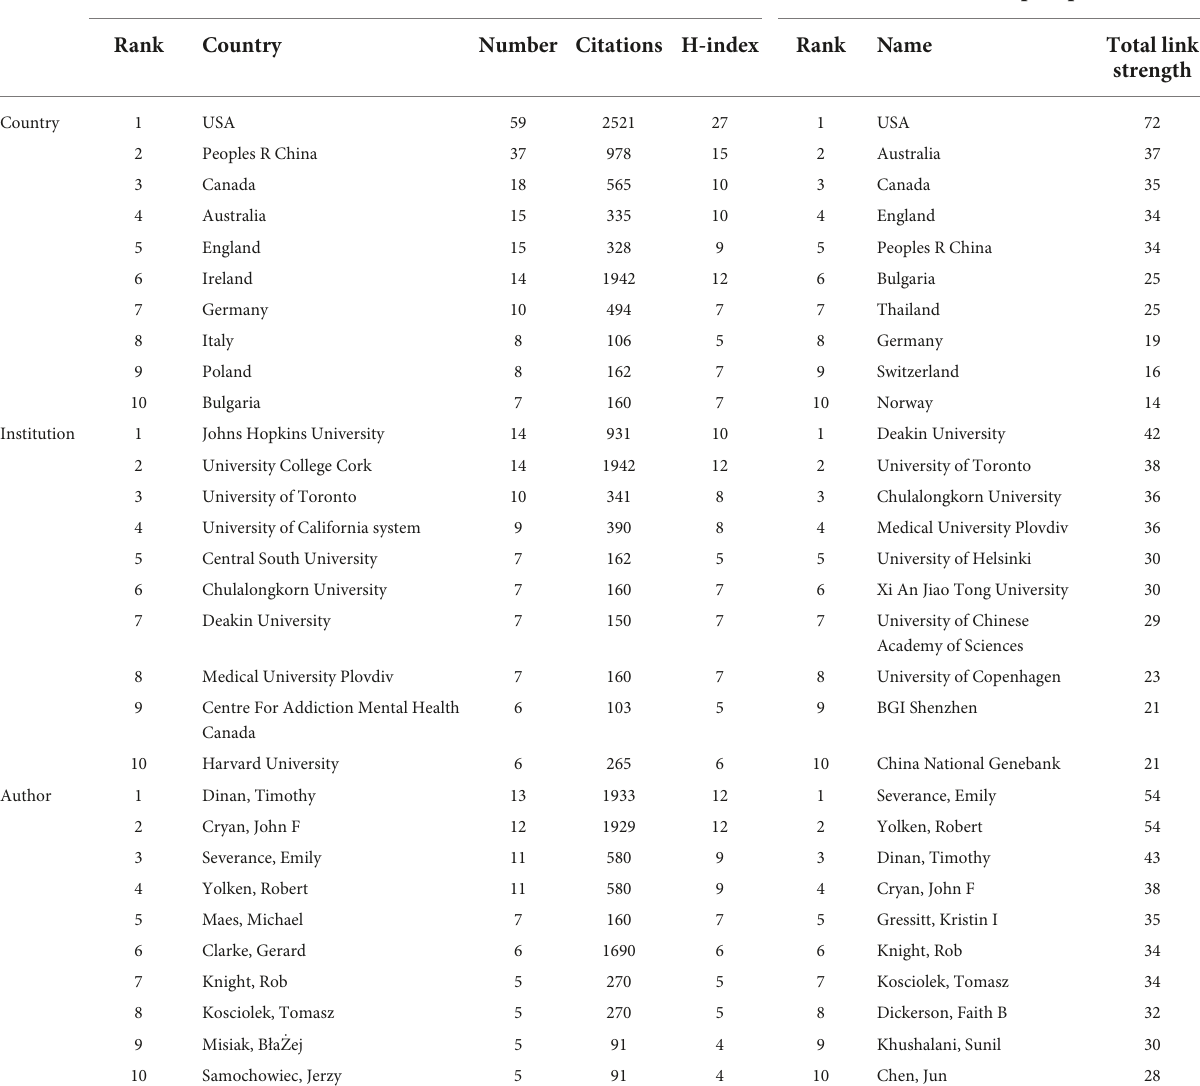
TABLE 1 Ranking of the top 10 authors, institutions, and countries.